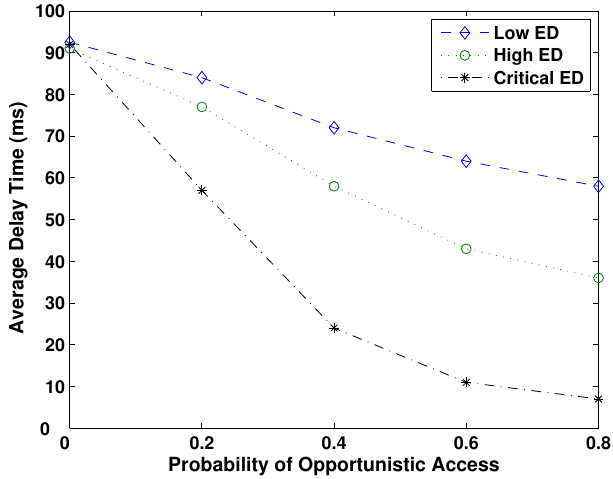
Figure 3. Average delay time as a function of the probability of opportunistic access, over BSR = 0.4. Critical ED nodes present the lowest average delay because they have priority on the resource’s